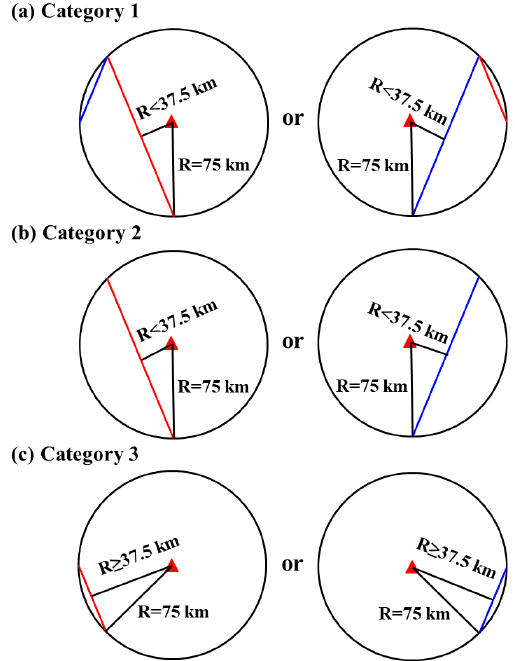
Figure 7. Schematic diagrams of three categories showing the lo- cation of Aeolus ground tracks relative to the RWP sites which are based on a circle with a radius of 75km centered at the RWP sites (red triangle) to match the Aeolus and RWP wind observations: (a) category 1, (b) category 2, and (c) category 3, in which the short- est distance from the ascending (red line) or descending (blue line) Aeolus ground track to its nearest RWP site is less or greater than 37.5km.